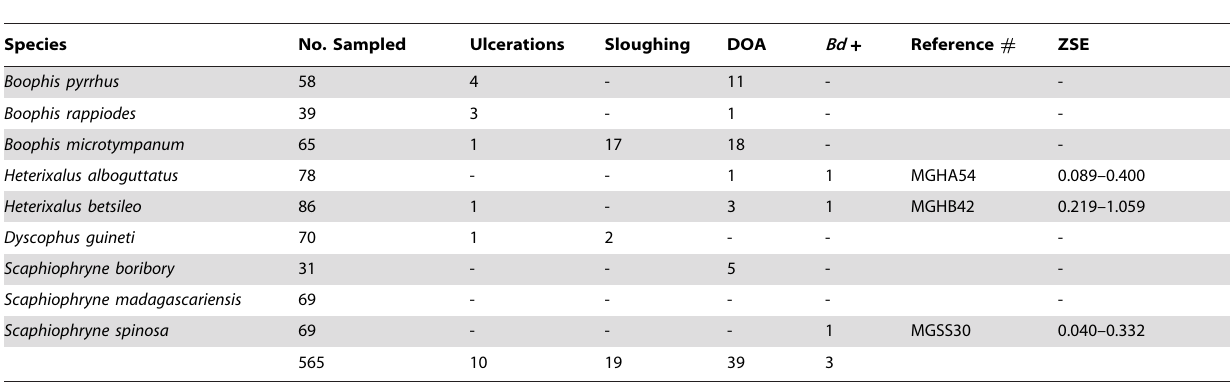
Table 1. Amphibians from Madagascar sampled for the presence of Batrachochytrium dendrobatidis ( Bd ).